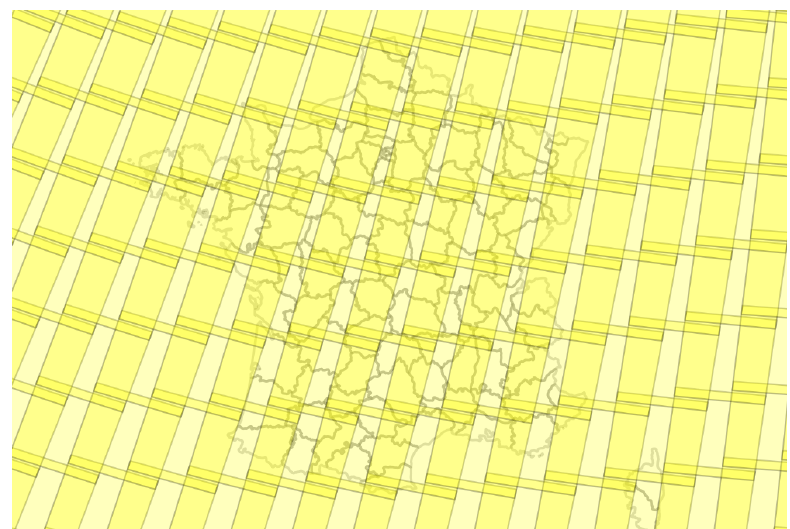
Figure 7. Path-row grid for Landsat acquisitions. Every path (North-South track) is acquired on the same date every 16 days. Adjacent paths are acquired 8 days apart.